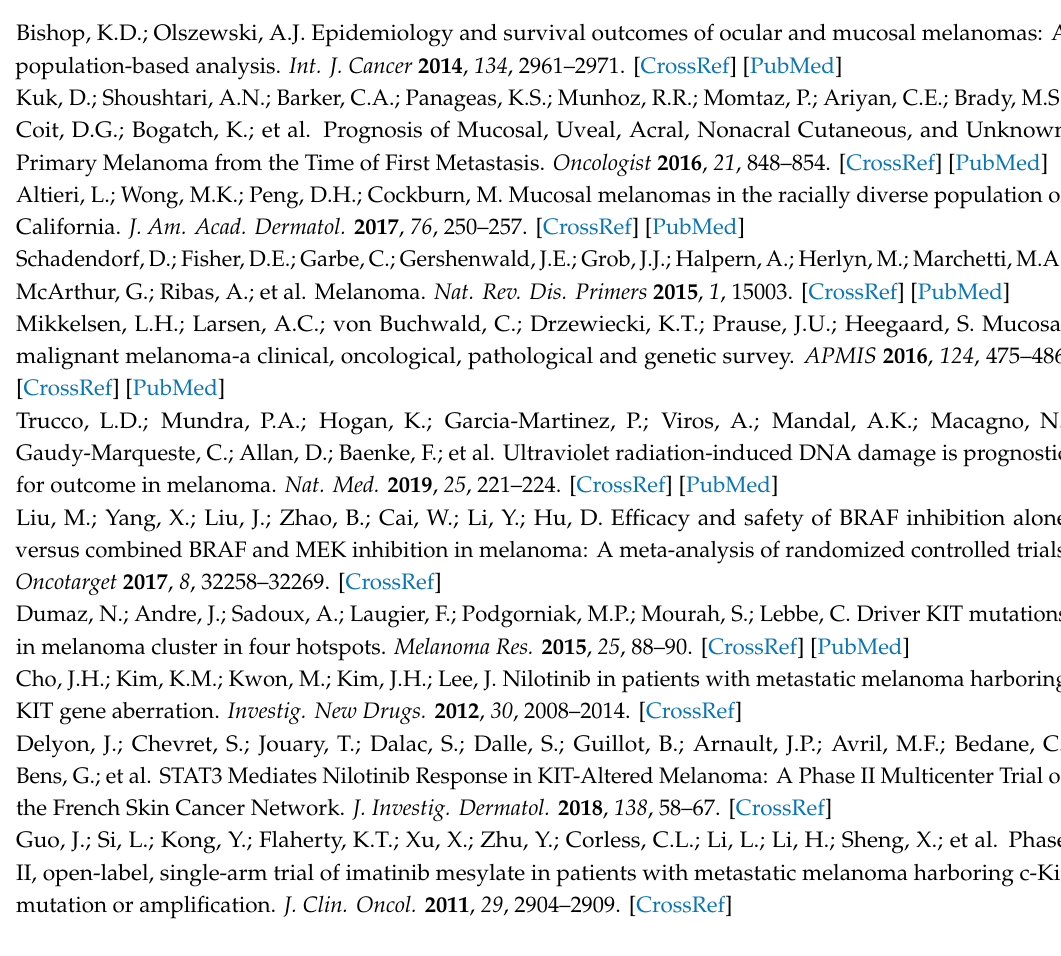
Table S1: NRAS mutations in mucosal melanoma, Table S2: BRAF mutations in mucosal